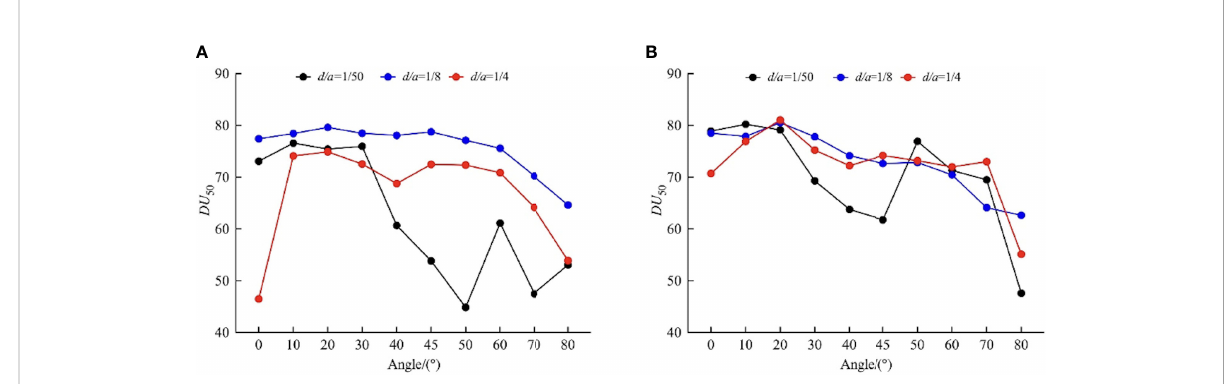
FIGURE 11 Distribution of the uniformity coef fi cient under different conditions: (A) Single-inlet mode; (B) Dual-inlet